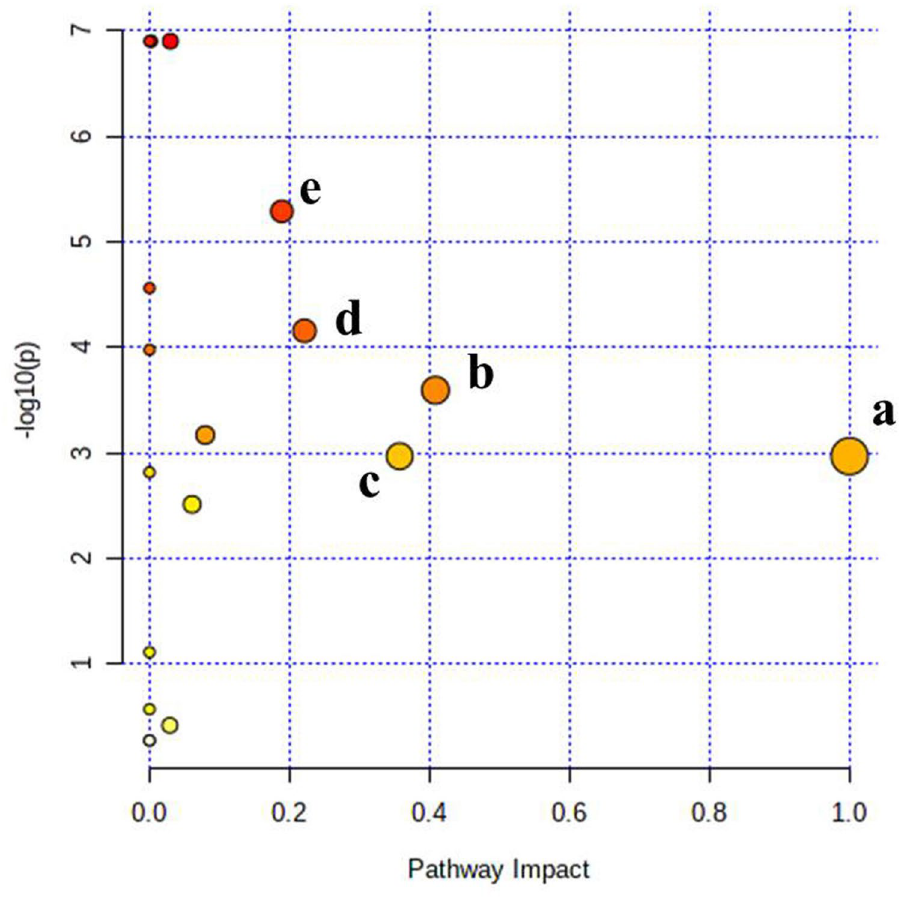
Figure 11. Summary of the metabolic pathway analysis and their impact on pregnancy with MetaboAnalyst 5.0. ( a ) Phenylalanine, tyrosine and tryptophan biosynthesis, ( b ) Tryptophan metabolism, ( c ) Phenylalanine metabolism, ( d ) Histidine metabolism, ( e ) Tyrosine metabolism.